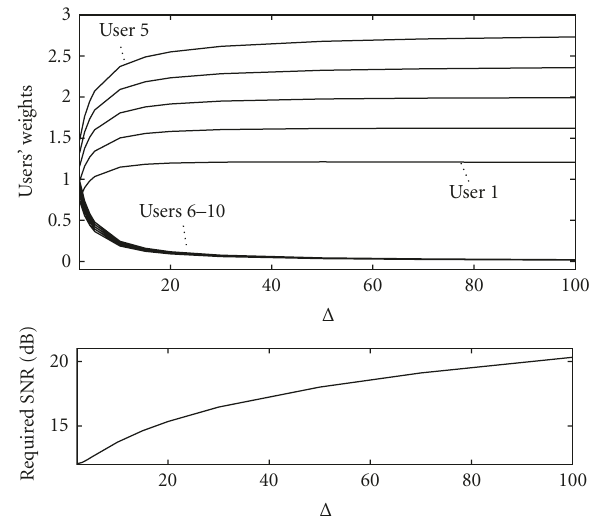
Figure 9: Mininum required average SNR and optimum scheduling weights to achieve the objective rates in di ff erent channels deter- mined by the parameters Δ